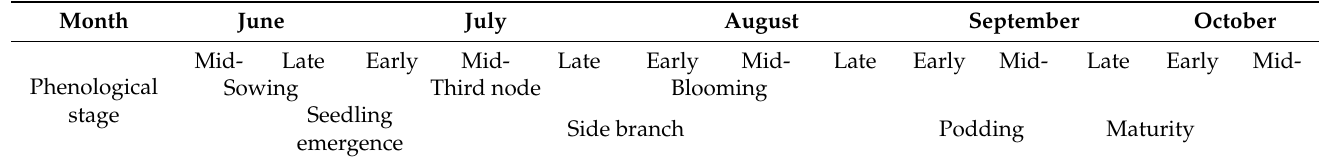
Table 1. Primary soybean growth stages in the study area.